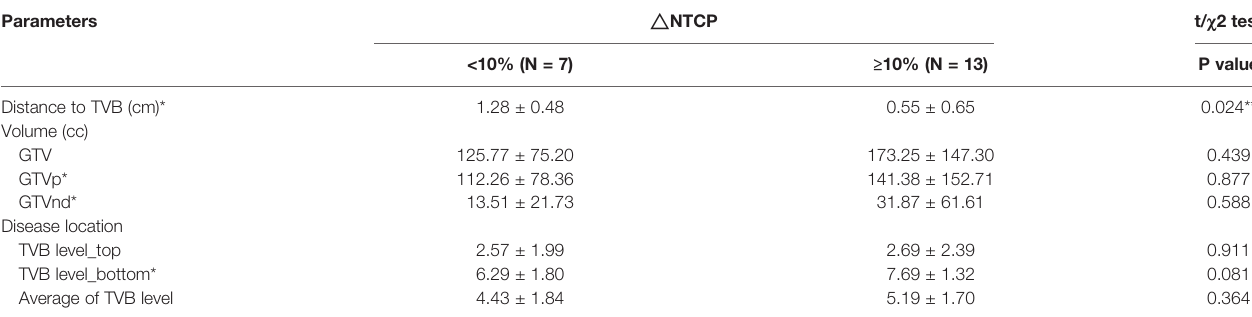
GTV,grosstumorvolume(includes primaryandnodalspread); GTVp, grosstumorvolumeofprimarysite;GTVnd,grosstumorvolumeofmetastaticlymph nodes;TVB, thoracicvertebral bodies; TVB level_top, the highest thoracic vertebra level that the disease across; TVB level_bottom, the lowest thoracic vertebra level that the disease across; Number of V, numbers of vertebrae of the tumor across; average of TVB level, the average of TVB level_top and TVB level_bottom. *Non-normaldistributionparameterswereanalyzedwithnonparametric tests(Mann-Whitneytest);Otherwise,normaldistributionparameterswereanalyzedwithindependent-samplettest. **p < 0.05; otherwise, p ≥